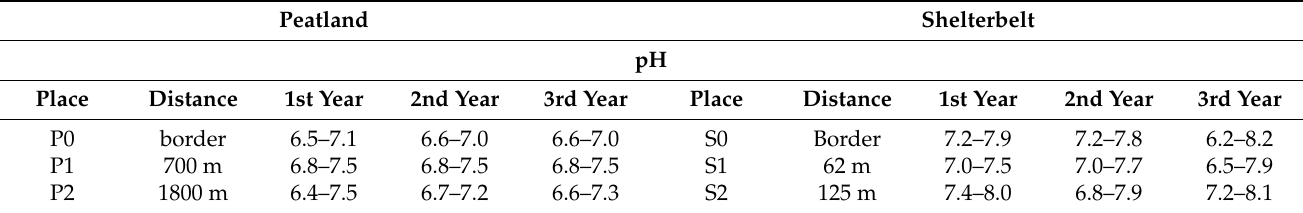
Table 3. The range of pH values in groundwater under peatland and shelterbelt.